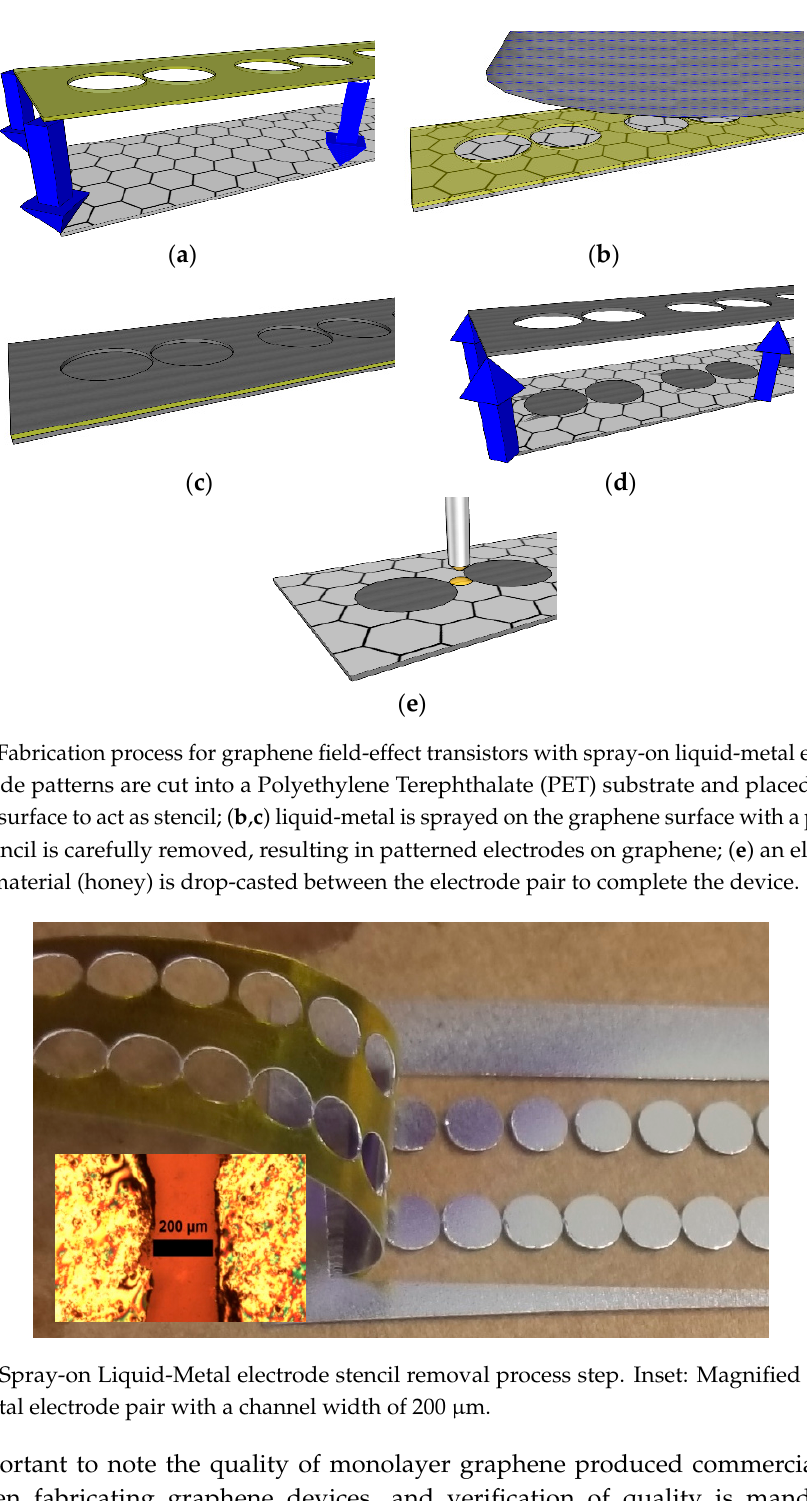
Figure 2. Spray-on Liquid-Metal electrode stencil removal process step. Inset: Magnified view of a liquid-metal electrode pair with a channel width of 200 μ m.